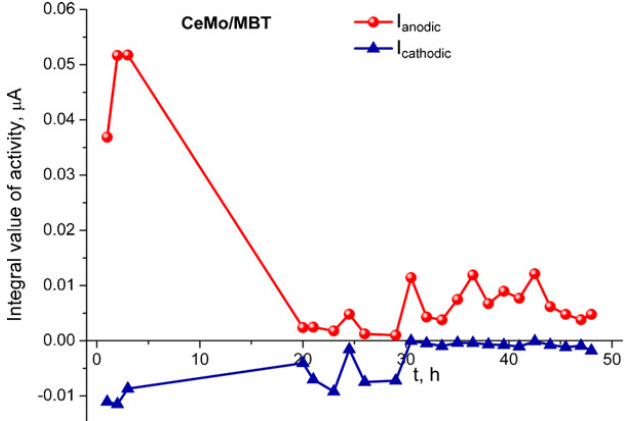
Figure 2. Evolution of the total anodic and cathodic current of the sample containing CeMo(MBT).